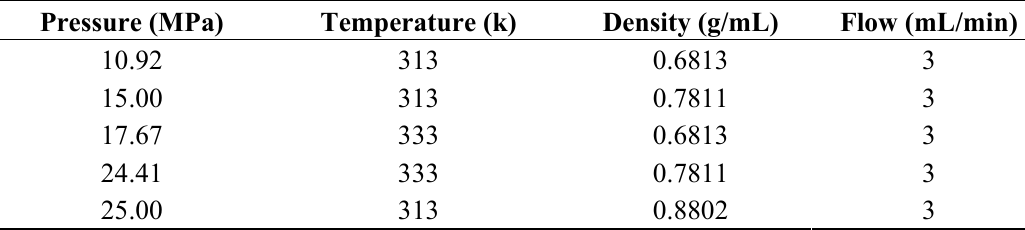
Table 6. Parameters used for the supercritical fluid extraction